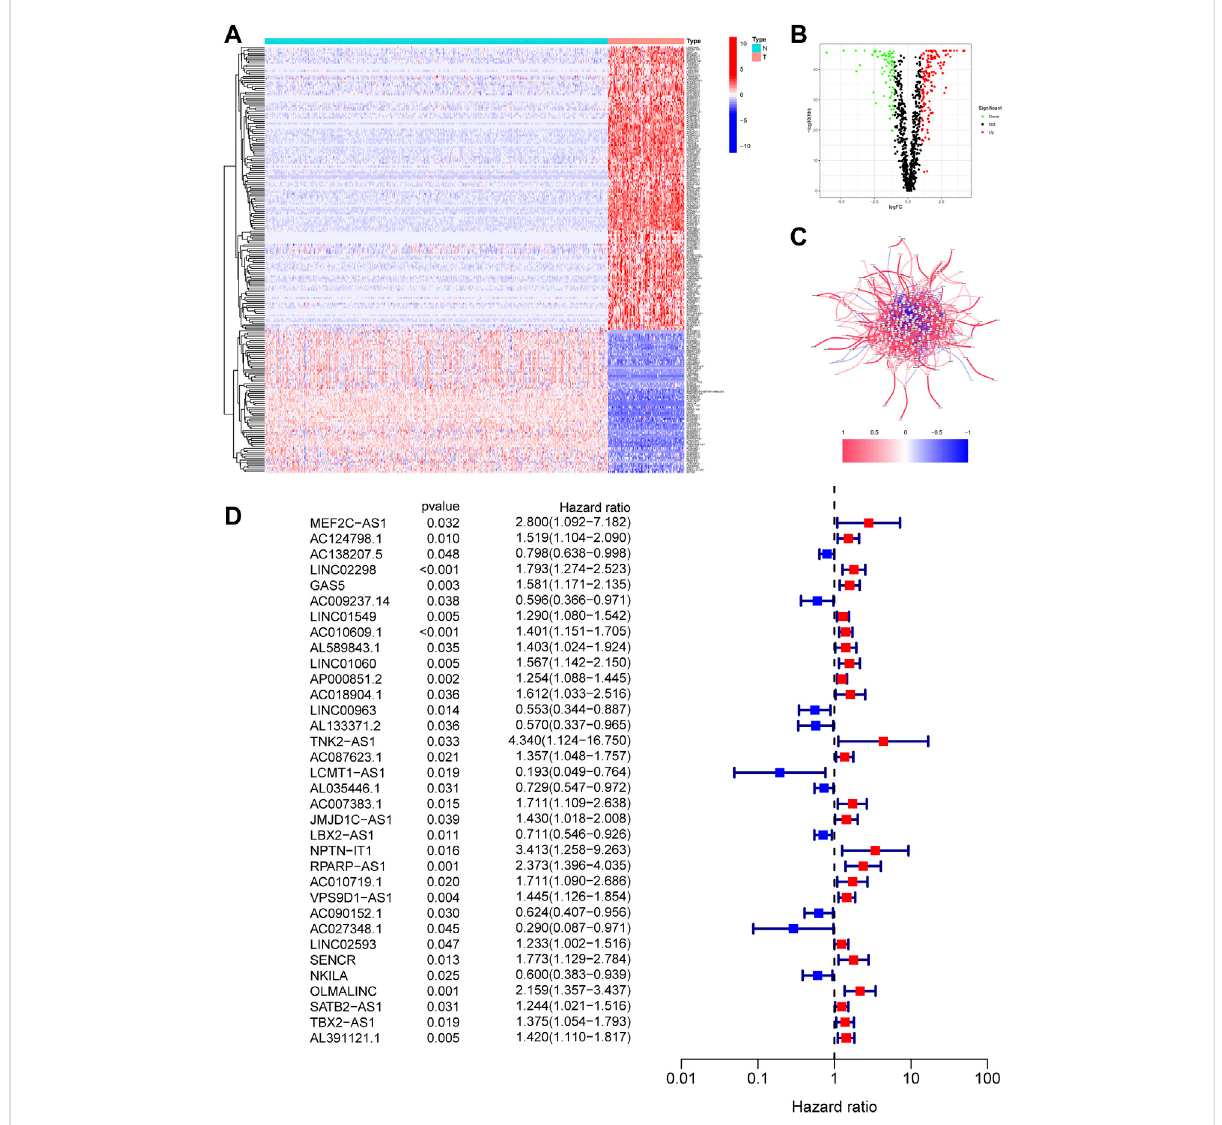
FIGURE 2 Identi fi cationofnecroptosis-related lncRNAsinOS. (A) .Theheatmapof218 differentiallyexpressed necroptosis-relatedlncRNAs.Trepresents tumor tissue, and N represents normal tissue. (B) . The volcano of 218 differentially expressed necroptosis-related lncRNAs. (C) . The correlation network between necroptosis-related lncRNAs. (D) . The prognostic lncRNAs extracted by univariate Cox regression